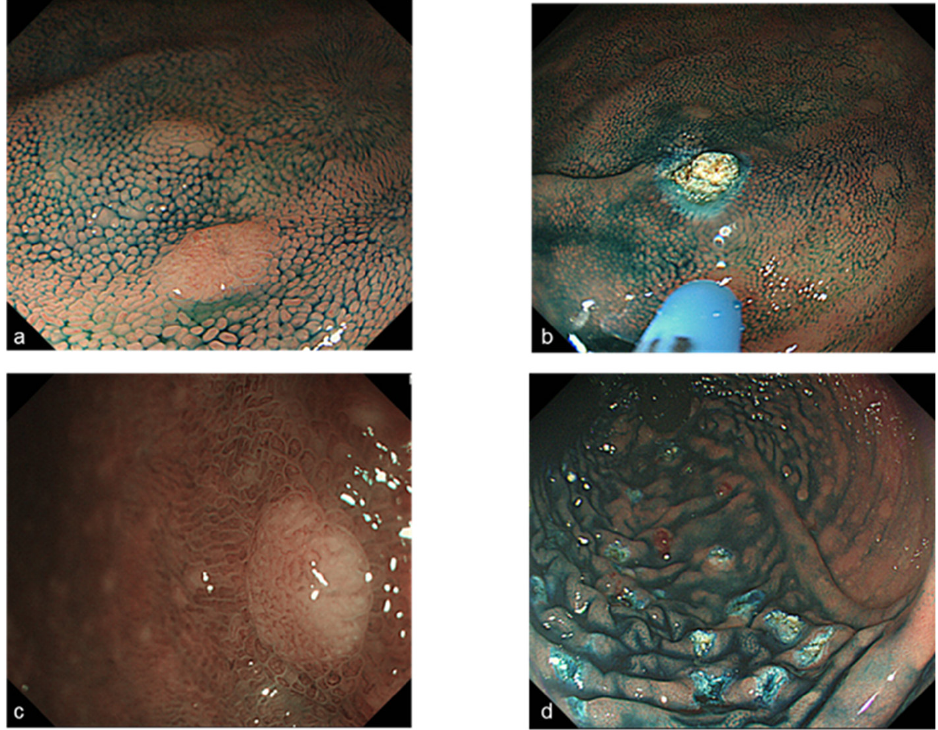
Figure 3. Endoscopic images before and after Argon plasma coagulation (APC) for tiny adenomas less than 5 mm ( a ) tiny polyp with indigo-carmine, ( c ) magnifying endoscopy image with narrow- band imaging shows JNET Type 2A (diagnosed as adenoma), ( b , d ) Endoscopic images after APC.